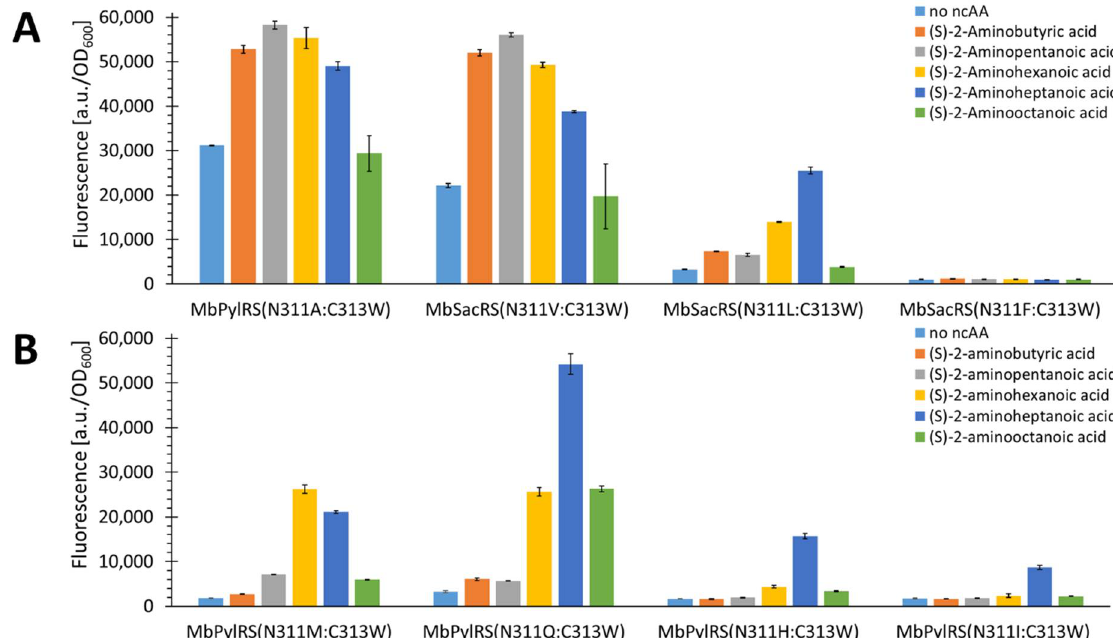
Figure 5. Comparison of aliphatic ncAA incorporation efficiency for Mb PylRS(C313W) constructs mutated at position N311. ( A ) Construct N311A with increased binding pocket size and additional mutations that stepwise decrease the size of the binding pocket. ( B ) Four additional active variants, found after screening of all 19 (all cAAs besides glycine) possible constructs. The fluorescence was measured for intact E. coli BL21(DE3) cells producing the SUMO-sfGFP(R2amber) reporter protein. The data (incl. standard deviation) represent the mean of three biological replicates.